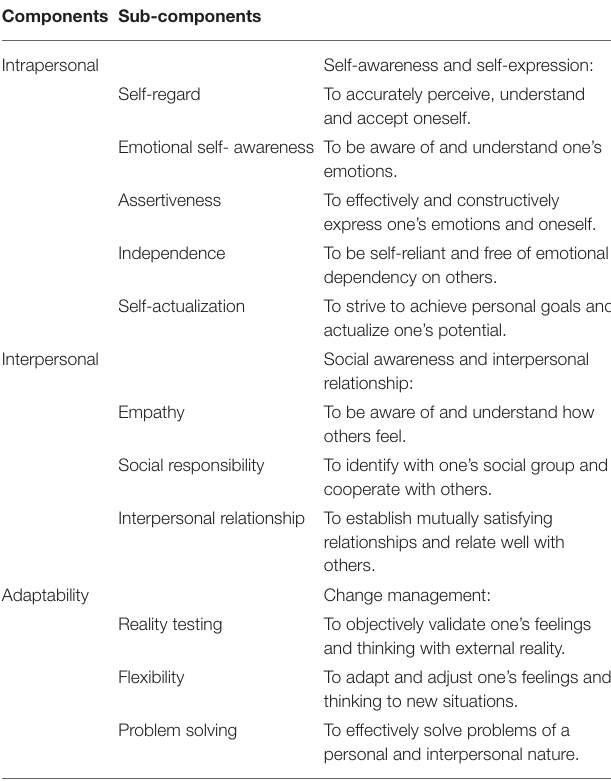
TABLE 1 | Three components of Bar-On’s model of emotional social